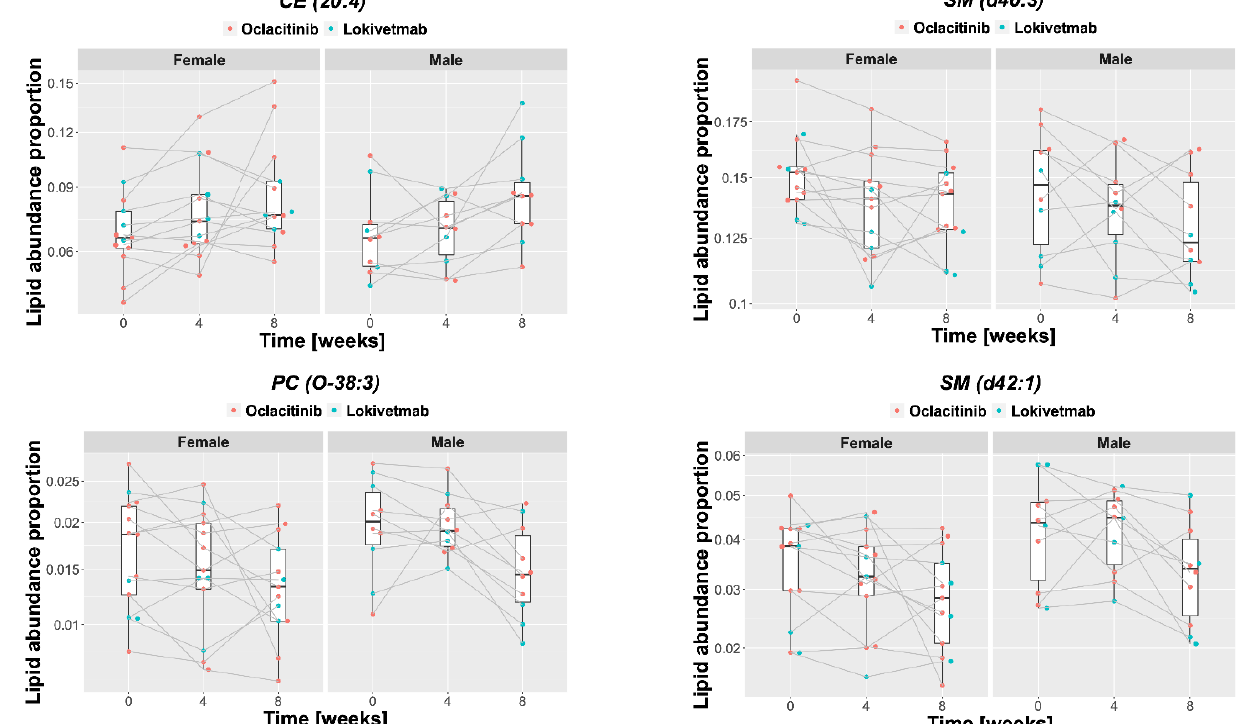
Figure 12. Examples of blood lipid with abundance changing significantly during the treatment.